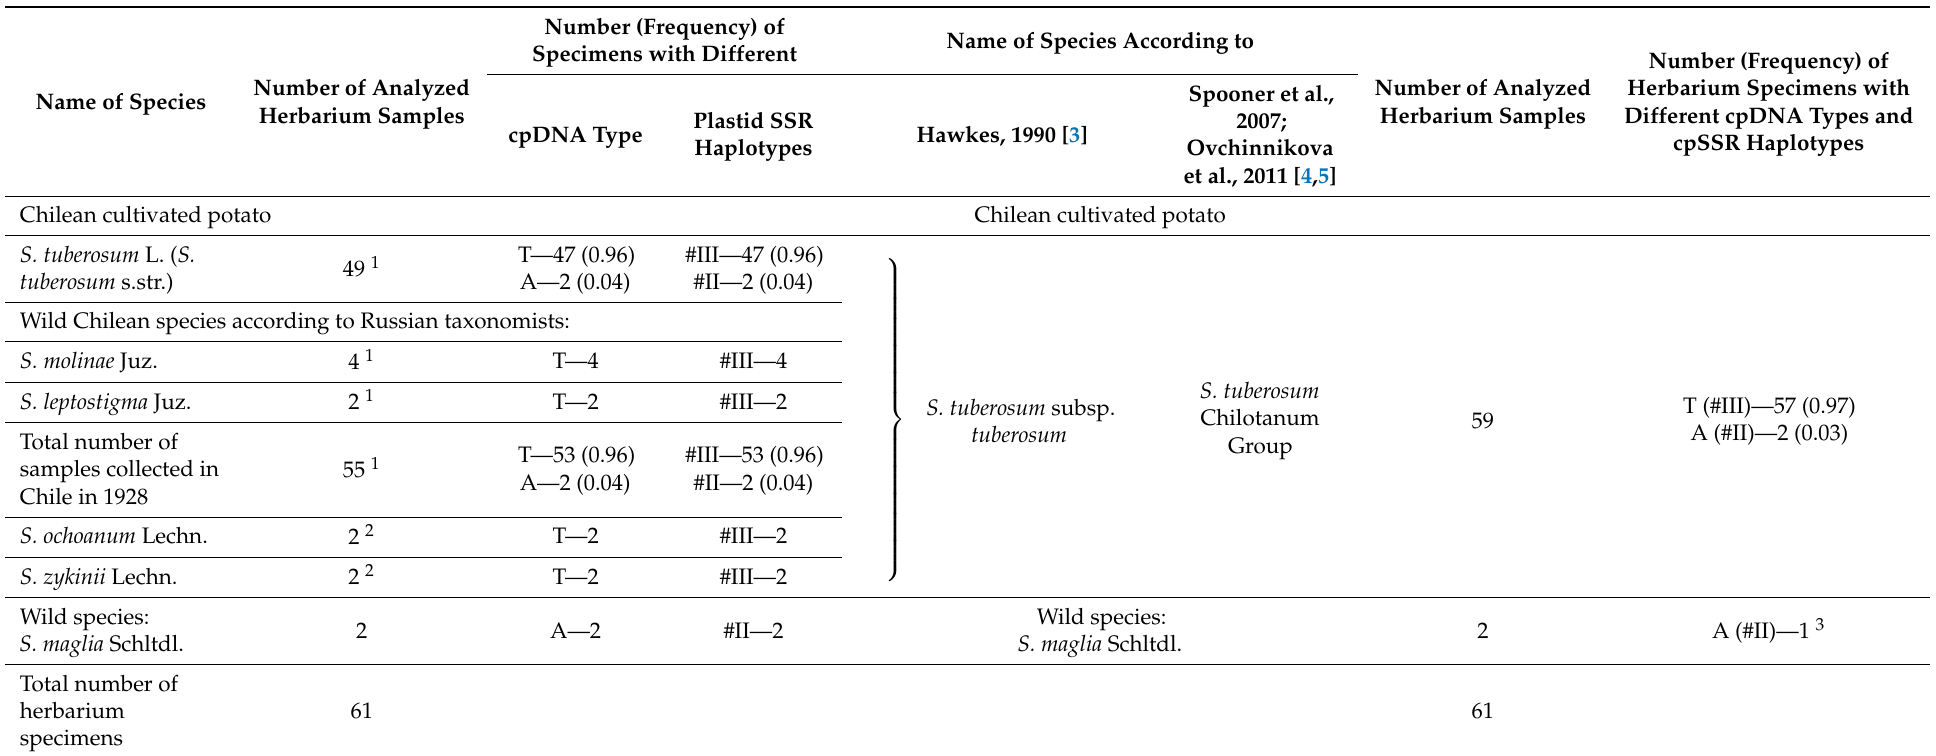
Table 1. Frequency of plastid DNA types and cpSSR haplotypes in Chilean potatoes based on the PCR analysis results of 61 herbarium